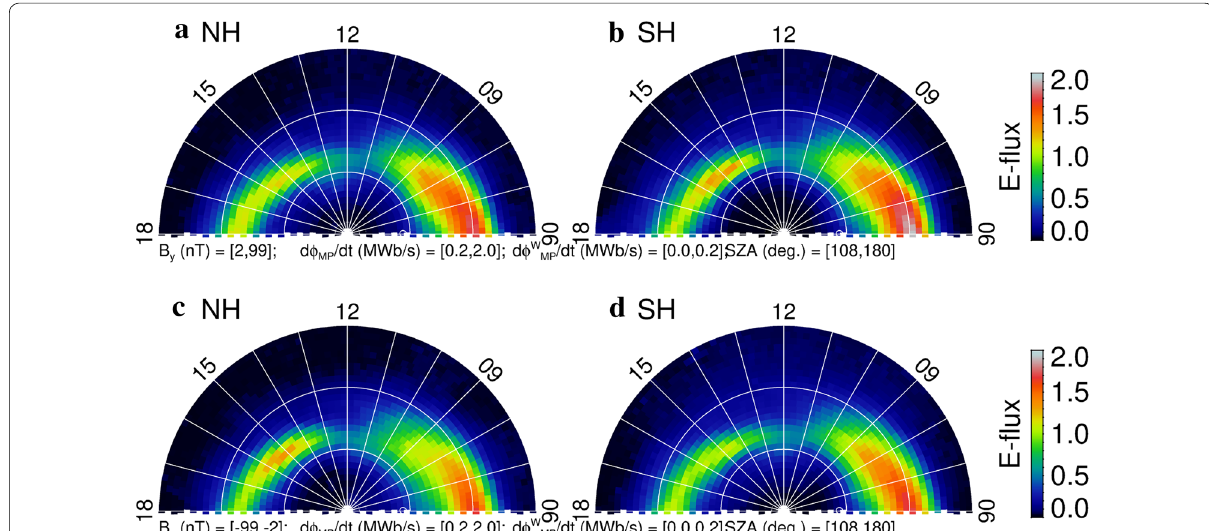
Fig. 3 Averaged electron energy flux (in erg/cm 2 -s) deposited into the dark (solar zenith angle: SZA > 108°) a Northern Hemisphere (NH) and the dark b Southern Hemisphere (SH) for positive IMF B y (> 2 nT). c , d Are in the same format as ( a ) and ( b ) but for negative IMF B y (<